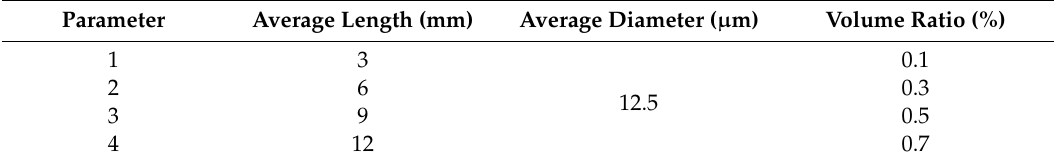
Table 3. Characteristic geometric parameters of polyacrylonitrile (PAN)